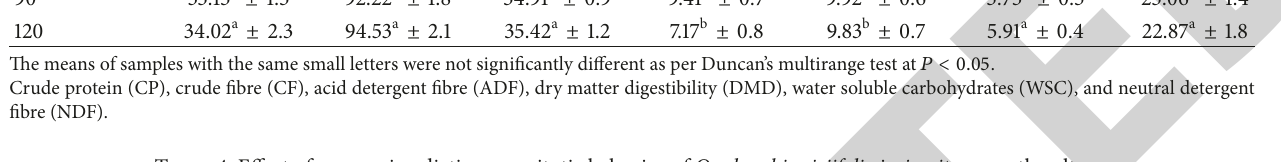
Table 4: Effect of gamma irradiation on mitotic behavior of Onobrychis viciifolia in in vitro growth culture. Gamma irradiation (Gy)